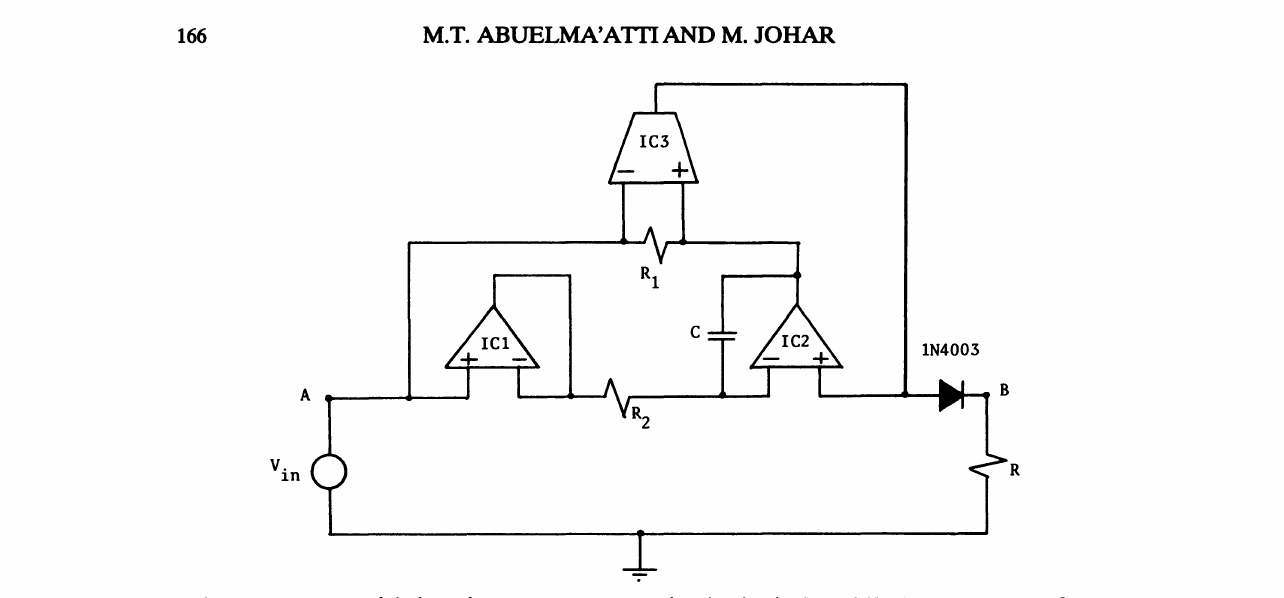
_k FIGURE 1 Proposed inductorless nonautonomous chaotic circuit R 2K, R 5K, R 151, C 1 nF IC1 and IC2:741 OA, IC3:3080